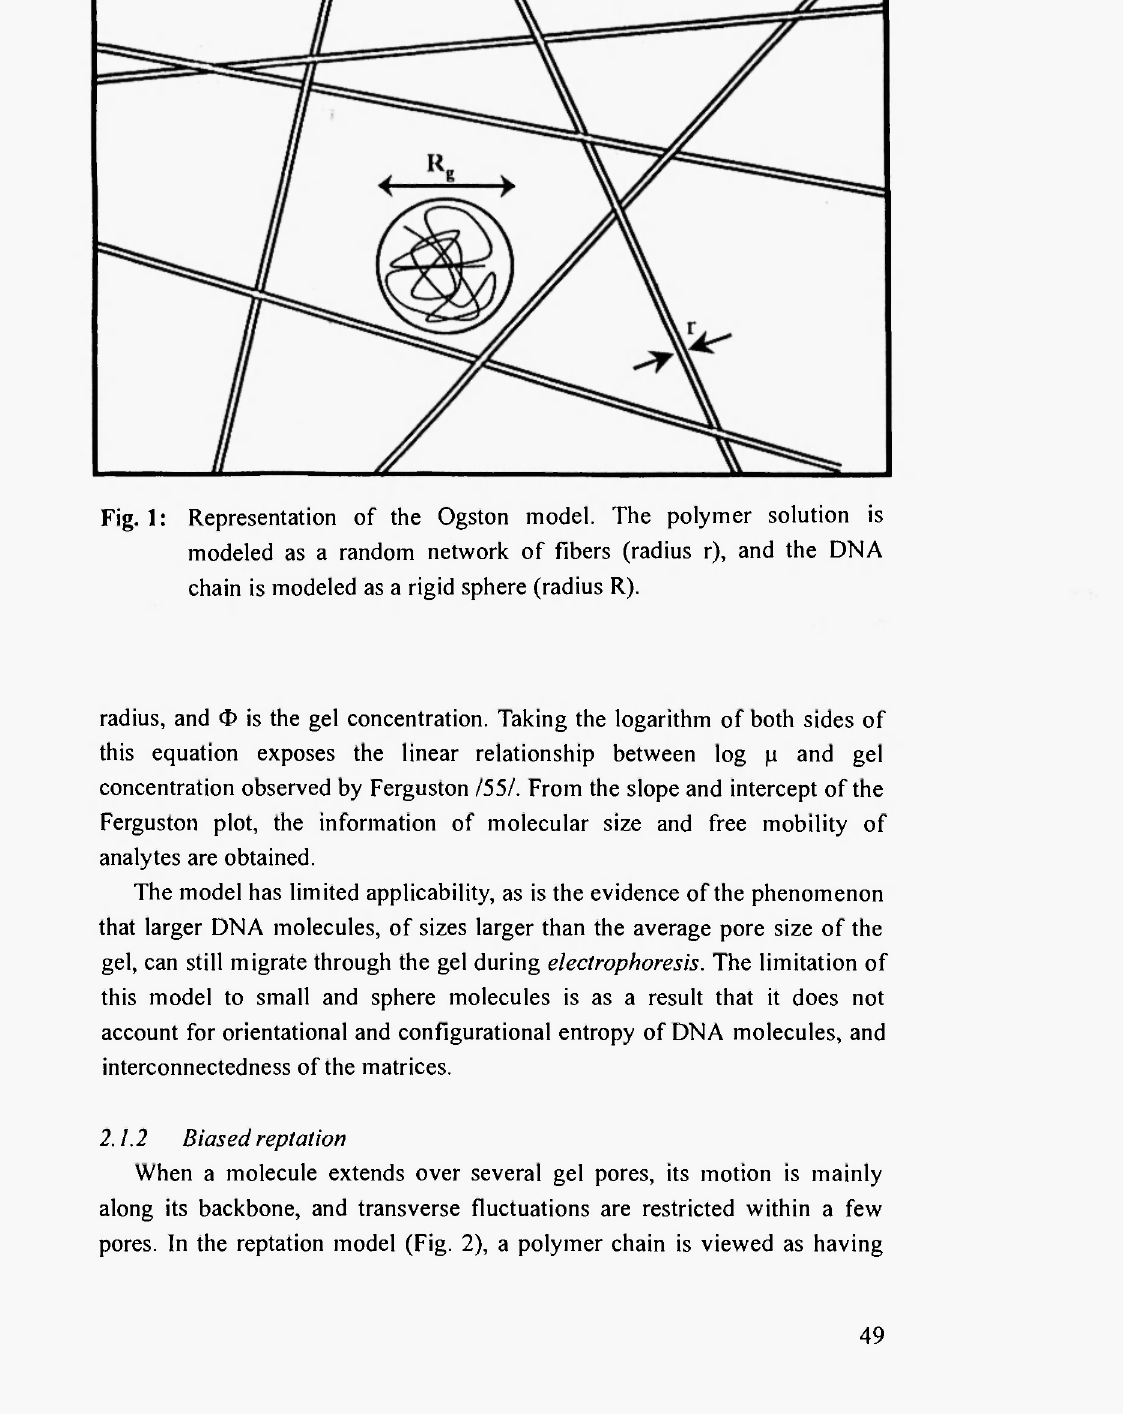
Fig. 1: Representation of the Ogston model. The polymer solution is modeled as a random network of fibers (radius r), and the DNA chain is modeled as a rigid sphere (radius R).